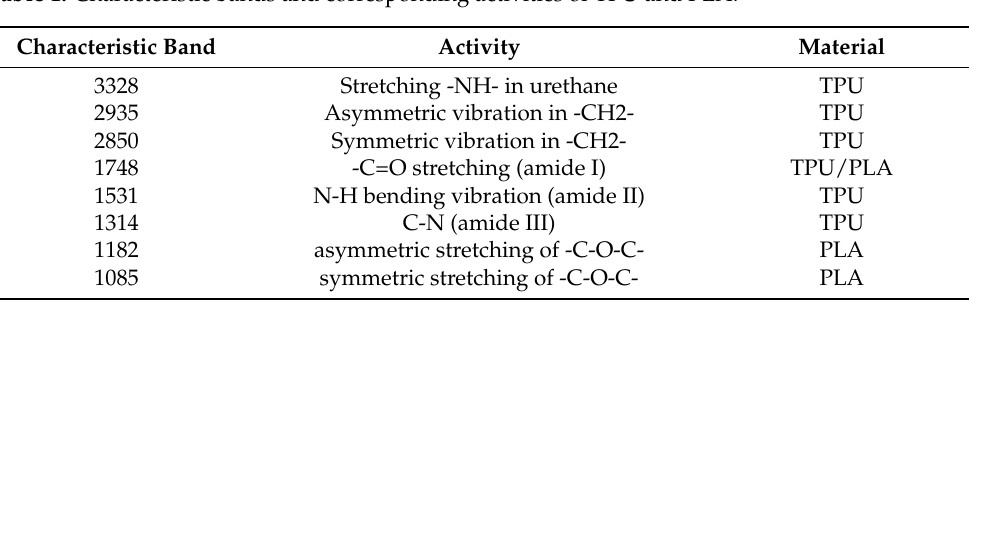
Figure 1. FTIR spectra of TPU, PLA, and TPU/PLA blends. Table 1. Characteristic bands and corresponding activities of TPU and PLA.